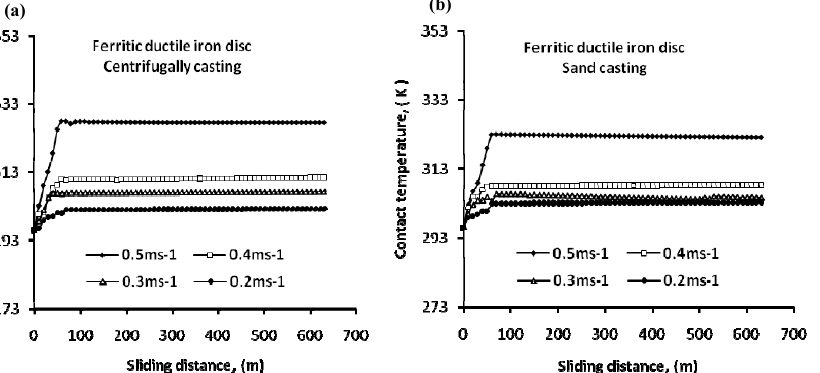
Figure 9. Evolution of the contact tempereture with sliding distance in different liner sliding speed for 40 N applied